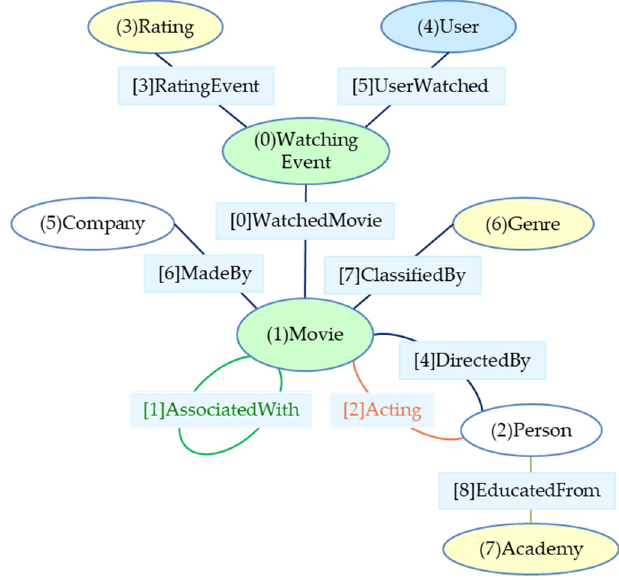
Figure 3. Ontology graph.